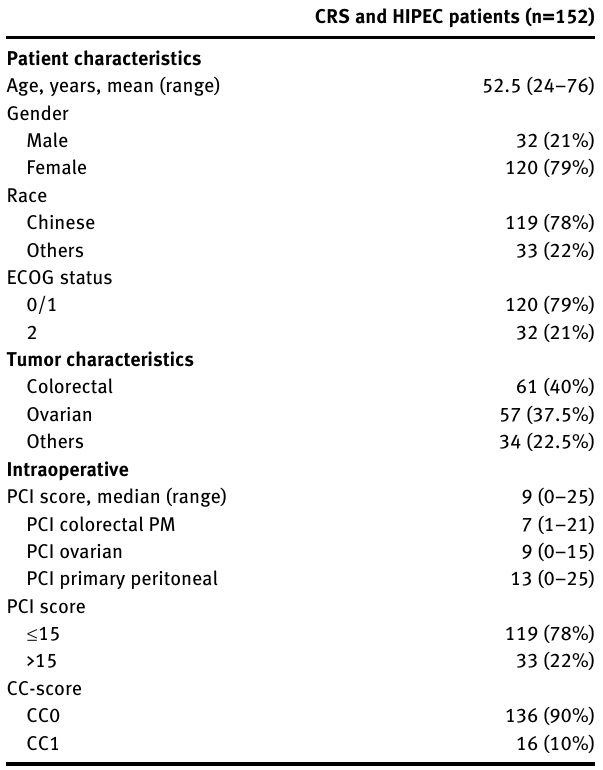
Table  : Demographics and clinical characteristics of CRS and HIPEC patients.